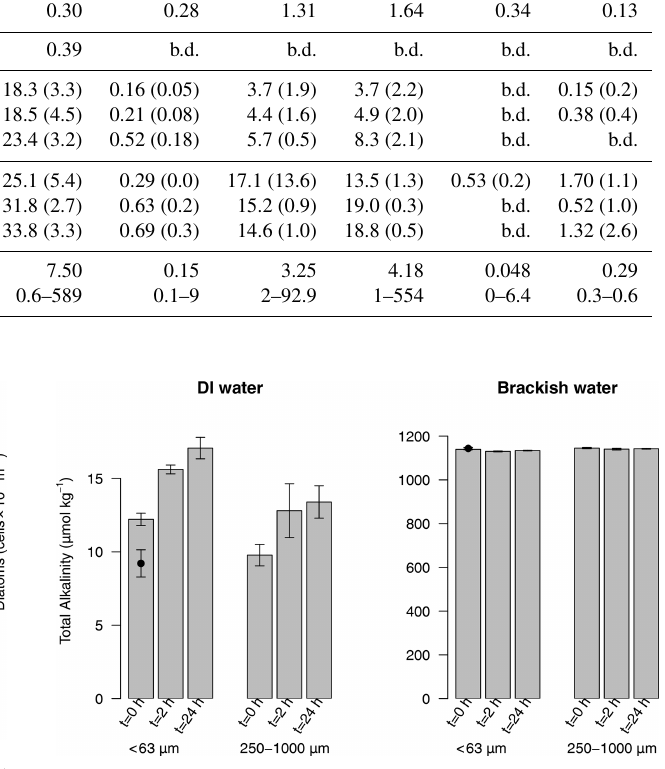
Figure 5. Total alkalinity released after leaching 4.5gL − 1 of ash of two size fractions ( < 63 and 250–1000µm) in deionised water (DI water) and brackish water. T 0 is “time zero” and was measured after 1min of mixing; T 2H was measured after 2h of mixing; T 24H was measured after 24h of mixing. n = 4 for all treatments (mean ± standard deviation plotted). The initial (pre-ash addition) alkalinity is marked by a black dot superimposed on the left T 0 . Source data are provided in the Supplement (Table